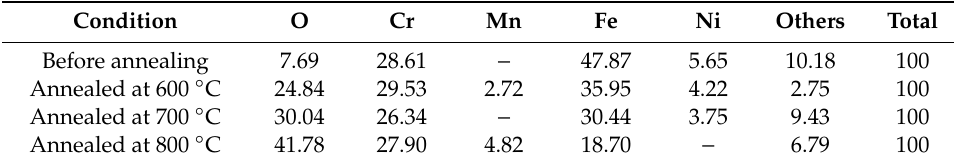
Table 2. Percentage of each element on the surface of the substrate.